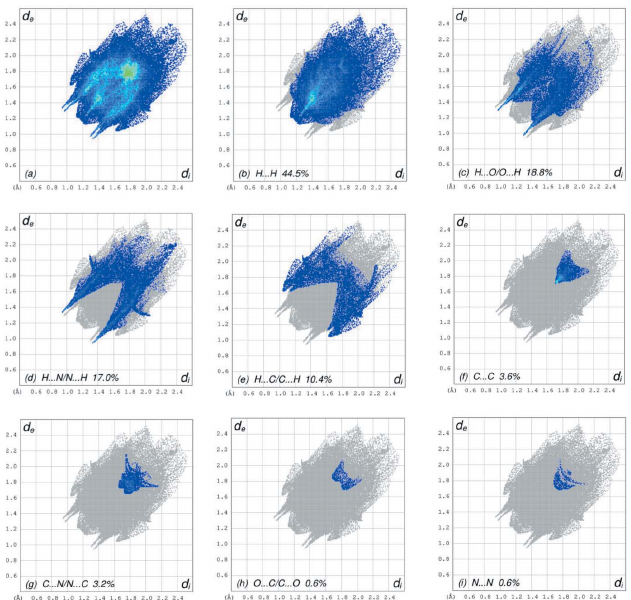
besides the H (cid:3) (cid:3) (cid:3) O/O (cid:3) (cid:3) (cid:3) H contacts (Table 2) and is viewed as pair of spikes with the tips at d N (cid:3) (cid:3) (cid:3) H contacts in the structure with 17.0% contribution to the HS have a symmetrical distribution of points, Fig. 7 d , with the